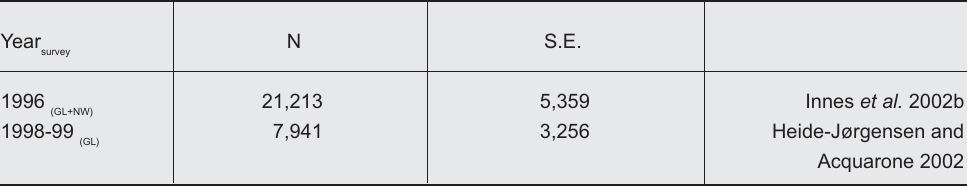
Table 1. Population estimates used in likelihood calculations (1996), based on aerial surveys, ad- justed for whales not at the surface and for whales at the surface but missed by observers and for comparison to SIR Bayes estimates.